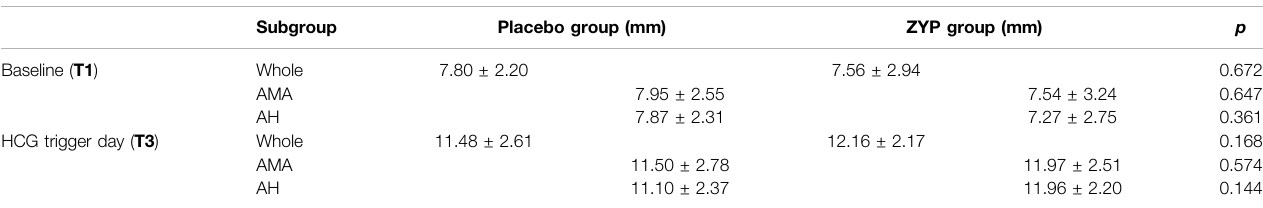
TABLE 3 | Thickness of endometrium on baseline (T1) and HCG trigger day